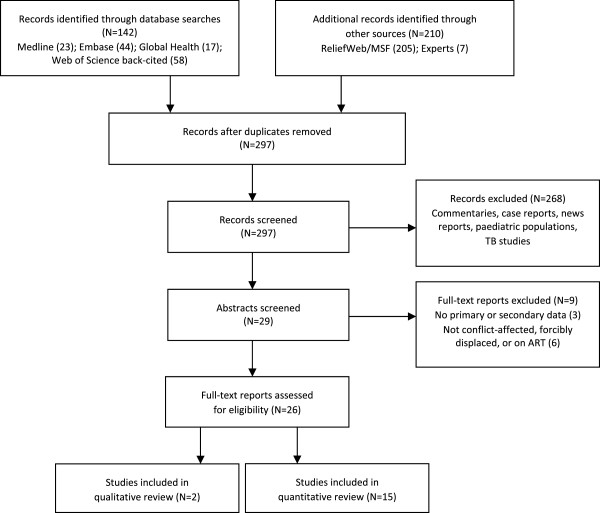
Study selection flowchart.